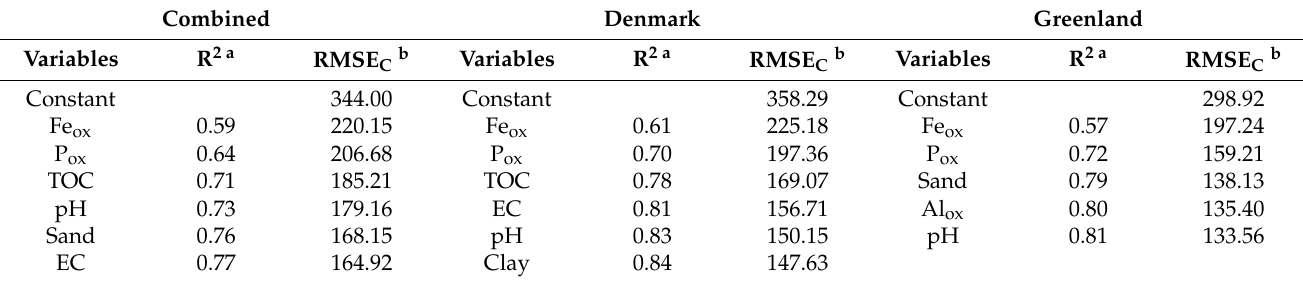
Table 2. Summary of the forward stepwise multiple linear regression (MLR) analysis to predict the K d (L kg − 1 ) when more and more soil properties are added one by one. The MLR model statistics are shown for the calibration subset of each